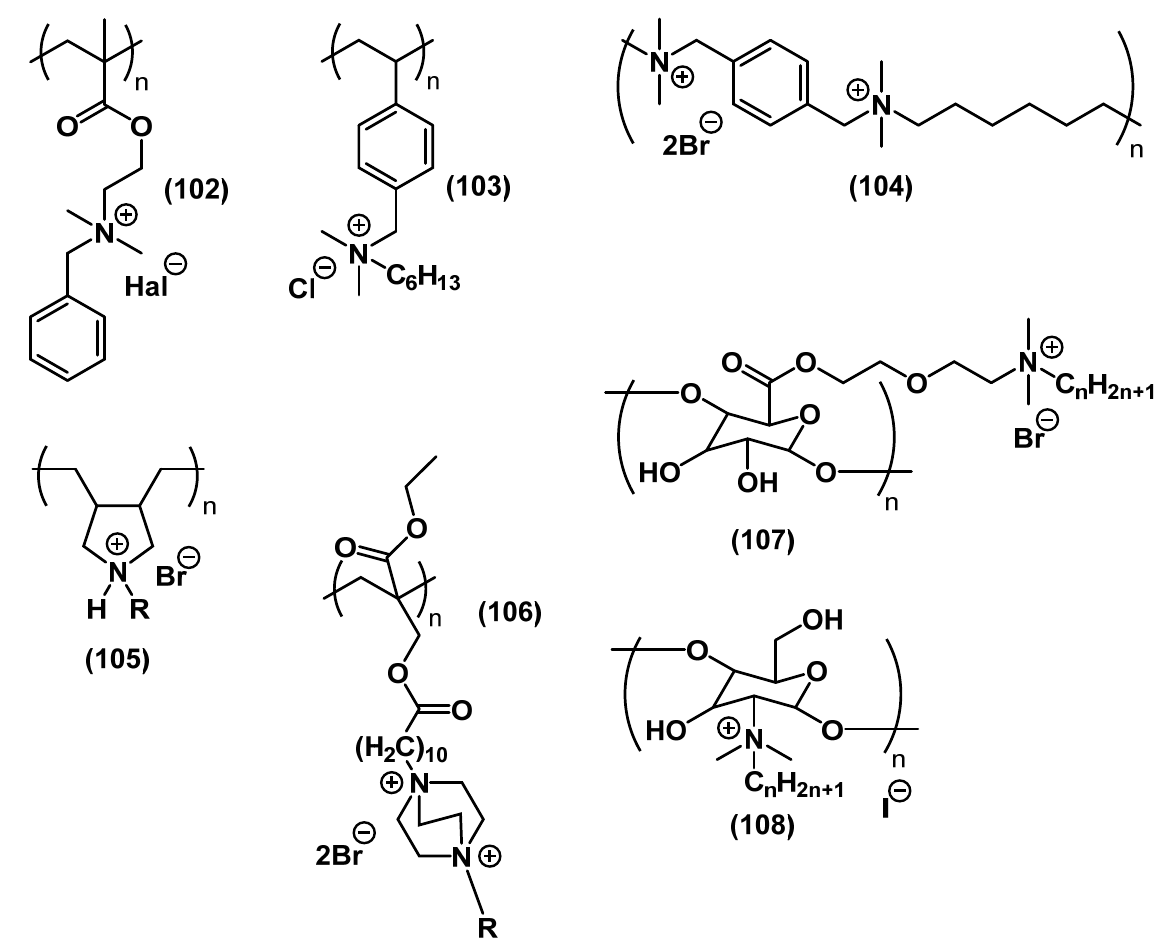
Figure 33. Spectrum of biologically active homogeneous poly-QACs.